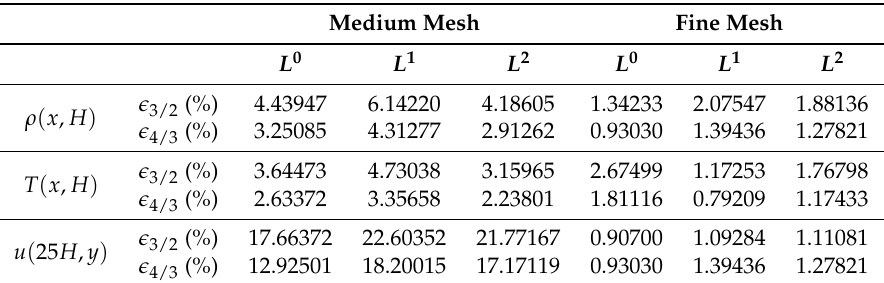
Table 7. Relative difference among L 0 , L 1 and L 2 norms of the absolute error achieved using second-order, two-stage SSP–RK, third-order, three-stage SSP–RK and fourth-order LSERK scheme. Results obtained using the medium and fine mesh density and temperature in the microchannel’s centerline and stream wise velocity in the cross section x = 25 H . Results obtained at the final time T f = 80 µ s with Kn = 0.05 and N =